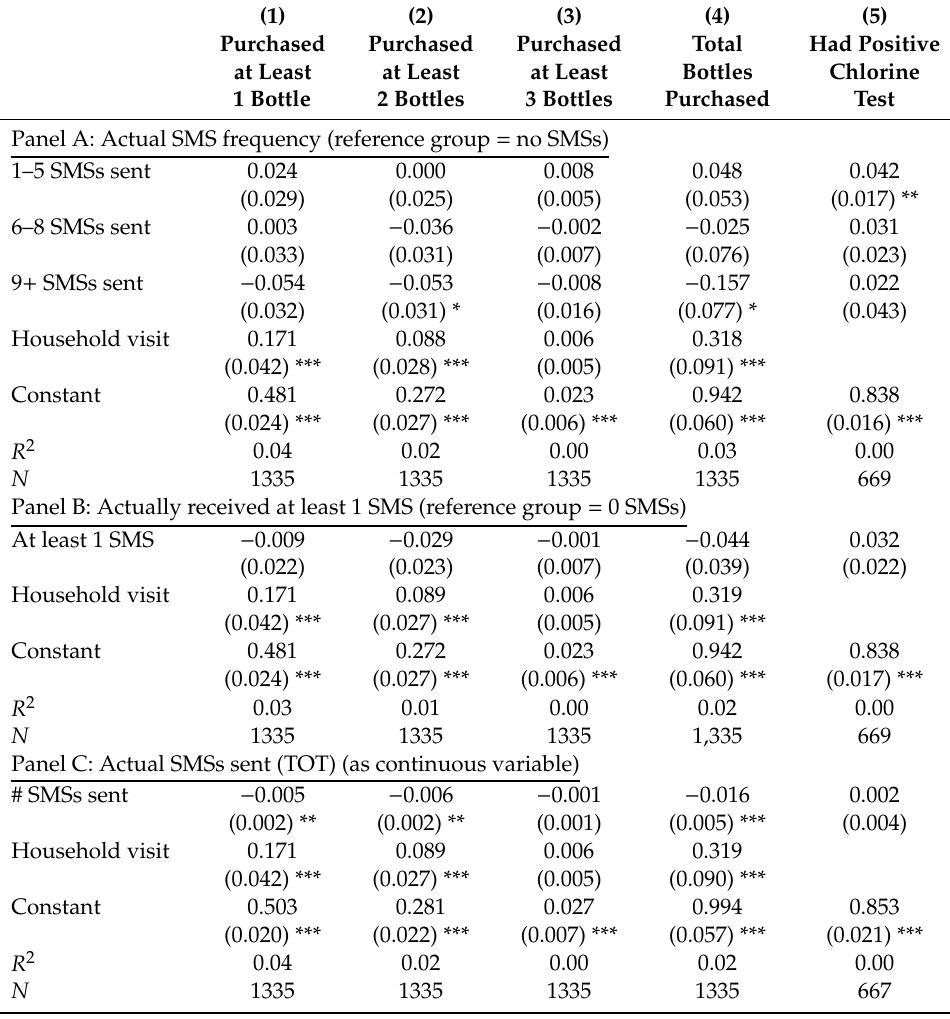
Table 4. Impact of di ff erent SMS frequencies (treatment-on-treated (TOT)